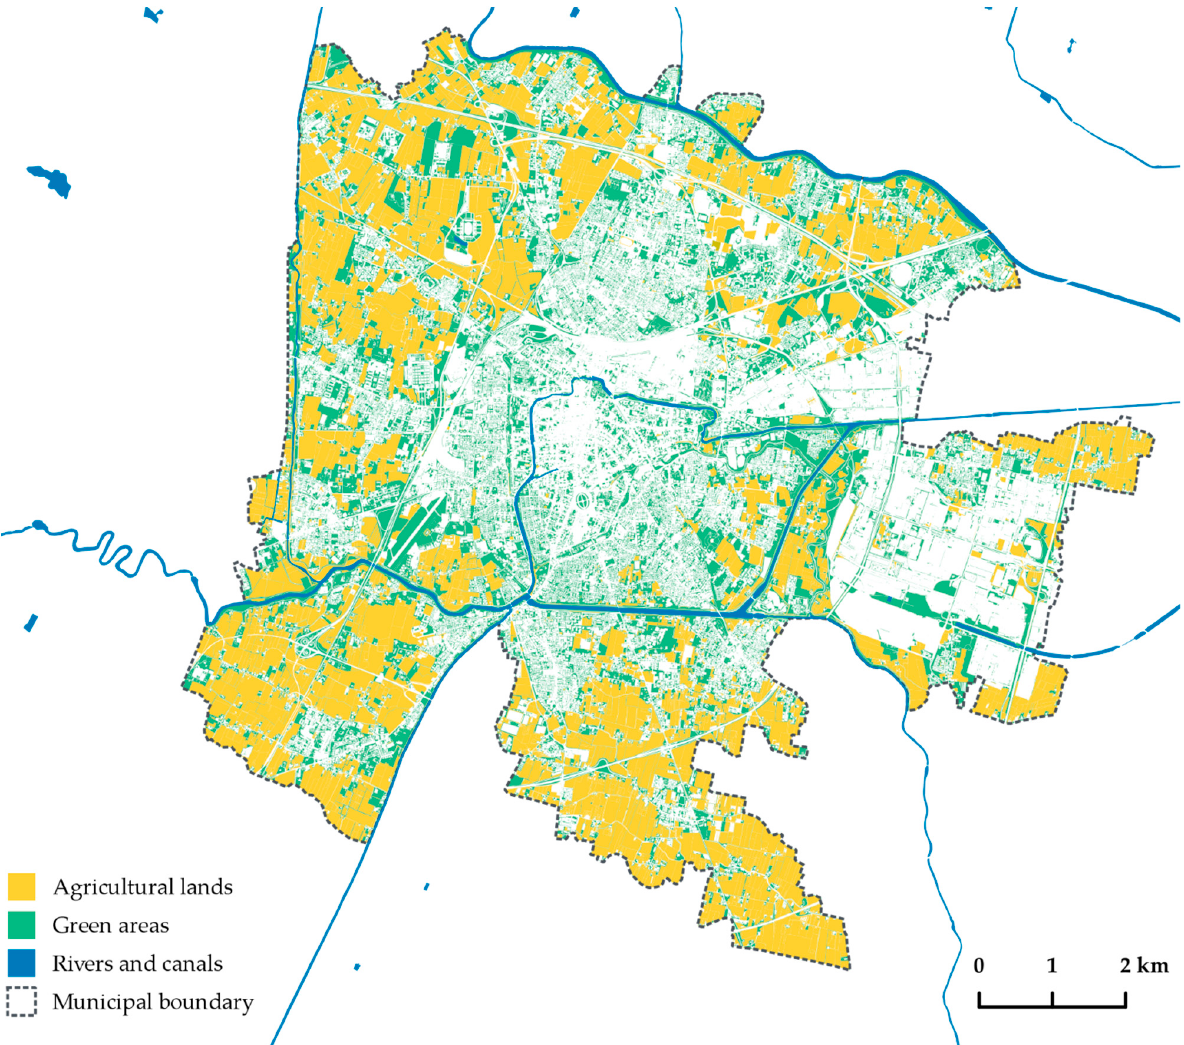
Figure 8. Map of rural and non-rural urban green spaces in Padua.